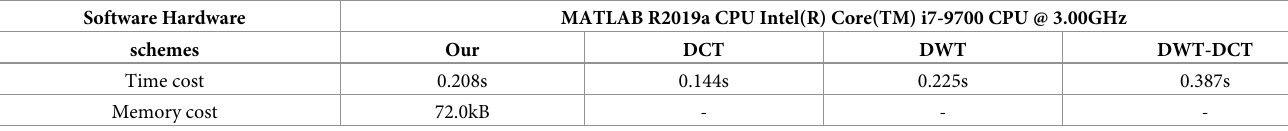
Table 4. The experimental environment and complexity comparison. Software